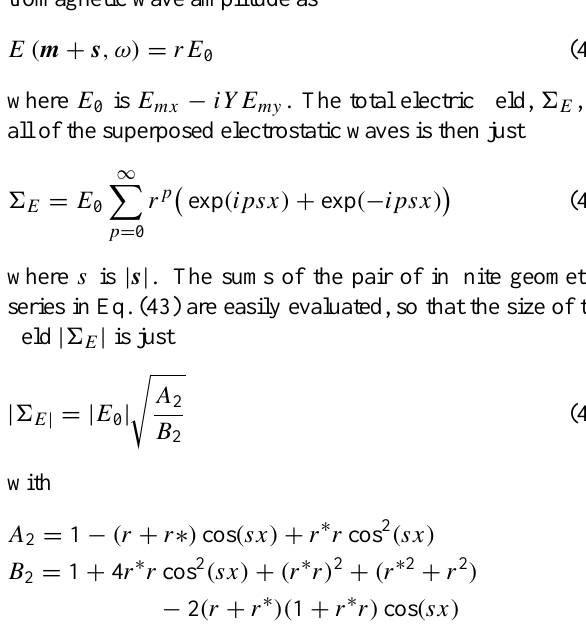
angle, α , of vector s 1 , in what follows, s 1 will be taken along the x -axis. Then, with the aid of Eqs. (18) and (28), the first order electrostatic field can be expressed in terms of the